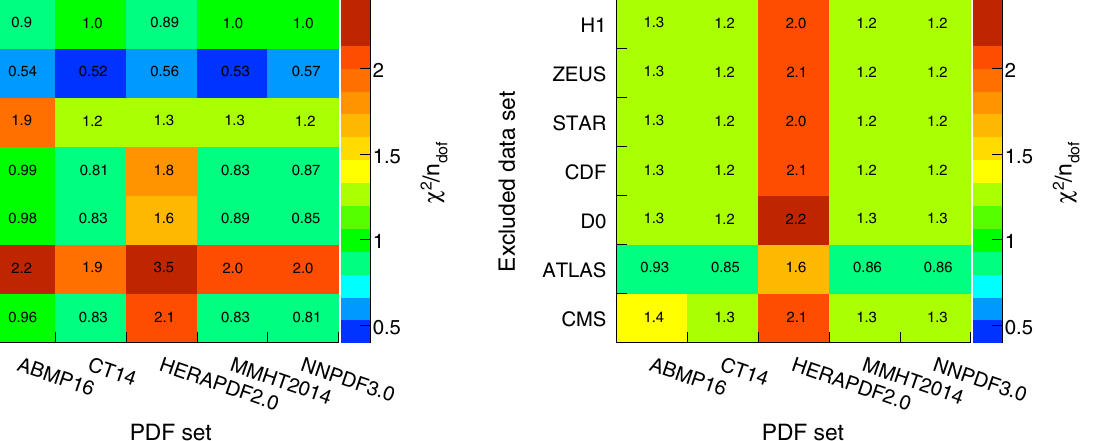
Fig. 3 Left: Illustration of the χ 2 / n dof values for fits to each data set individually. Right: Illustration of the χ 2 / n dof values for simultaneous fits omitting a single data set at a time. The included or respectively